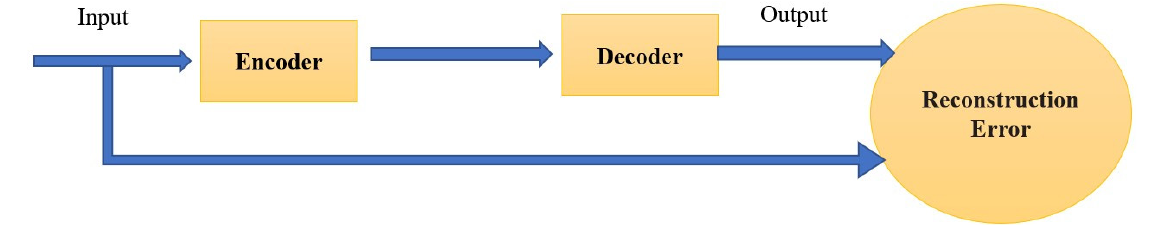
Figure 2. The visualization description of Autoencoder.